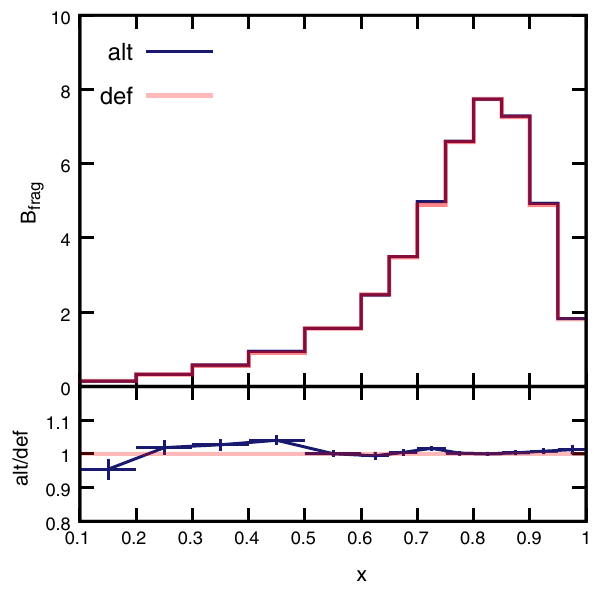
Fig. 6 B fragmentation function in top quark decay as defined in Ref. [17], produced withthe bb4l generator for the 8 TeV LHC. The default andalternativeimplementationofradiationfrom b quarksarecompared